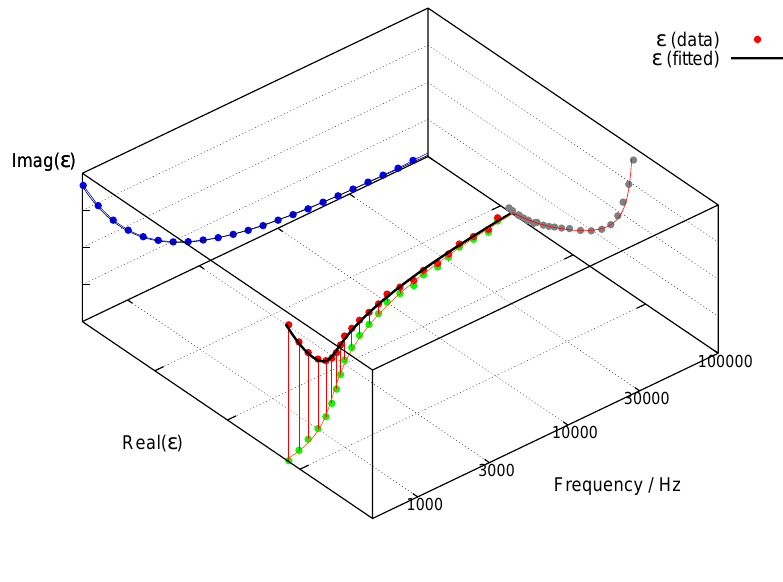
Figure 7 . Dielectric function plotted from data in Figure 6, fitted to Havriliak– Negami ’s